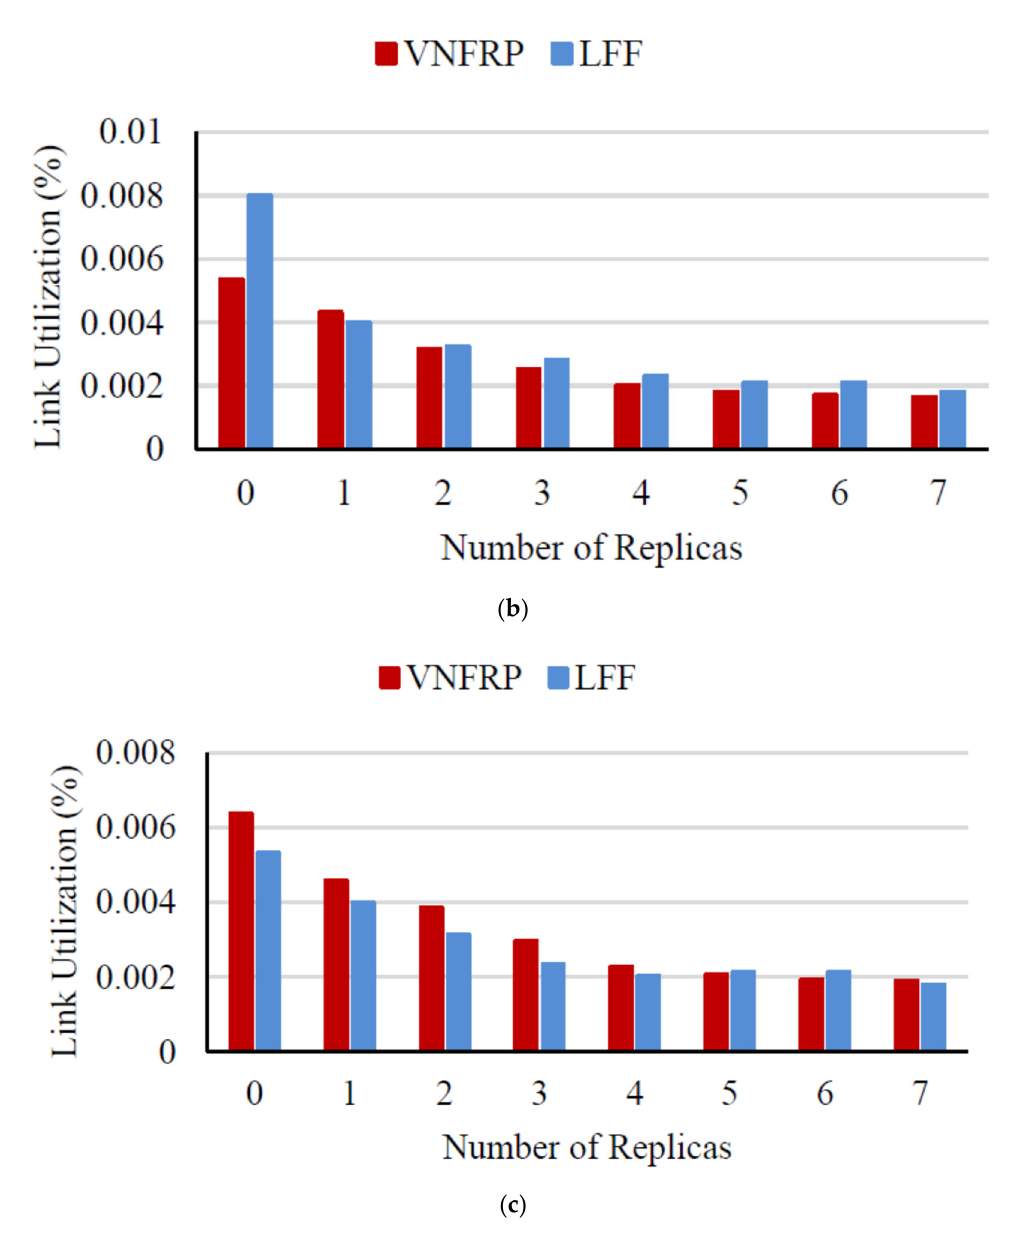
Figure 3. Link utilization when adopting the VNFRP algorithm and the corresponding values when adopting the least full first (LFF) strategy: ( a ) Level 1, ( b ) Level 2, and ( c ) Level 3.